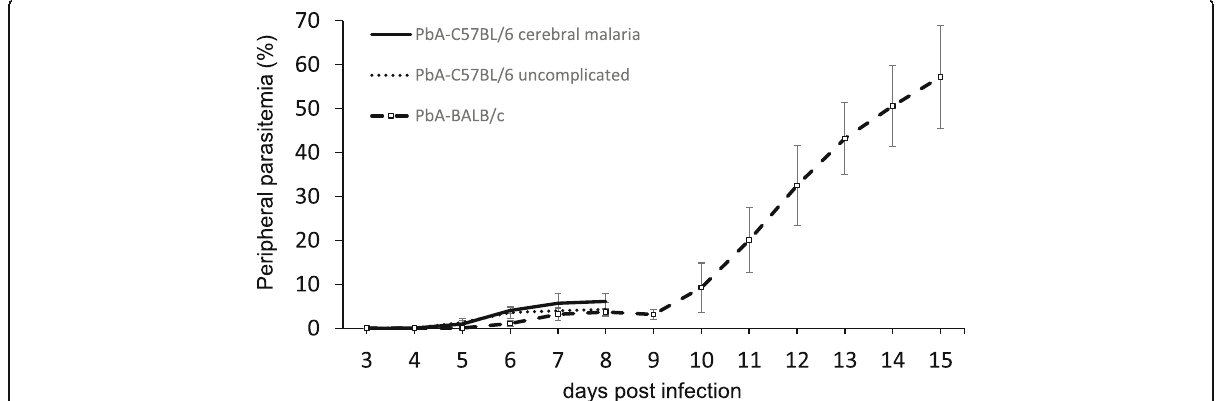
Fig. 1 Peripheral parasitemia. Parasitemia of PbA-C57BL/6 mice with cerebral malaria ( n = 6) and uncomplicated malaria ( n = 9) from day 3 until day 8 post infection is shown with SD. Parasitemia of PbA-BALB/c mice from day 3 until day 15 post infection is shown with